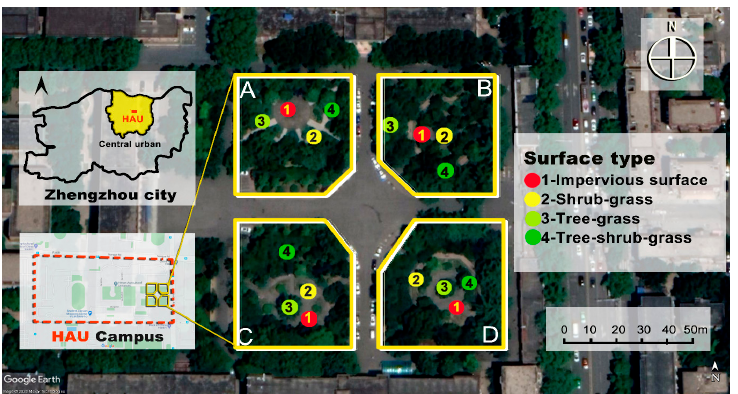
Figure 1. Location of the study area and the 16 measurement sites, four coverage types in four similar size gardens ( A , B , C , D ) in HAU campus.